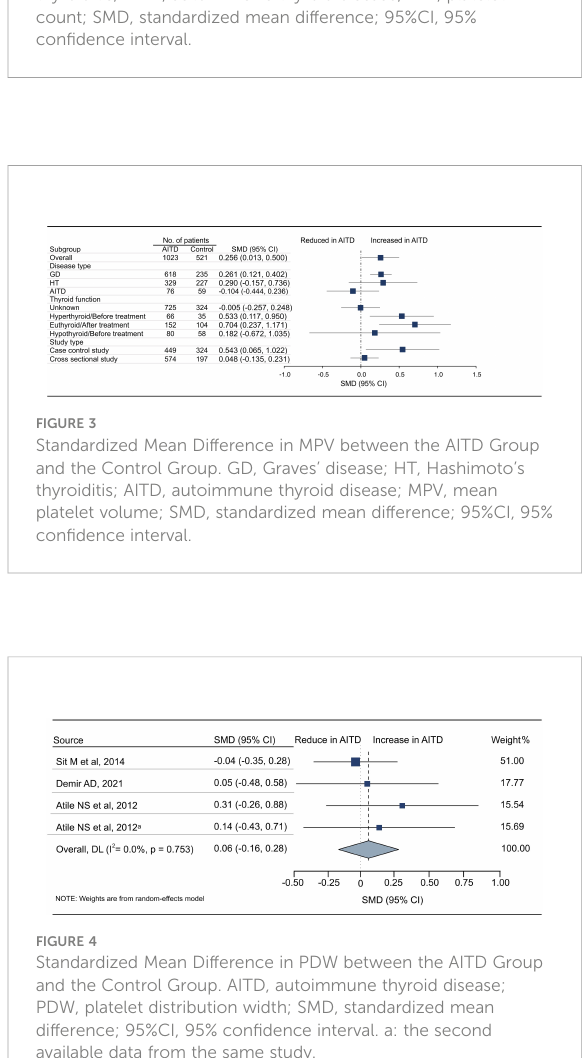
95% CI: 0.134 to 0.267) and Turkey group (SMD: 0.253, 95% CI: 0.128 to 0.377), and cross sectional group (SMD: 0.254, 95%